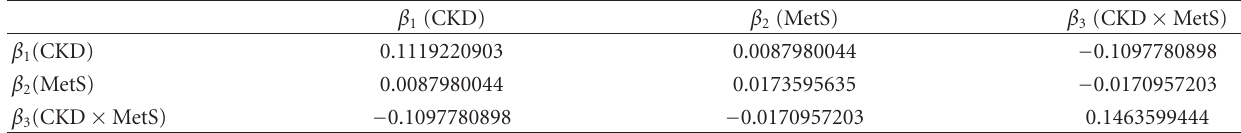
Table 5: Covariance matrix of the set of β coe ffi cients from the proportional hazards models.